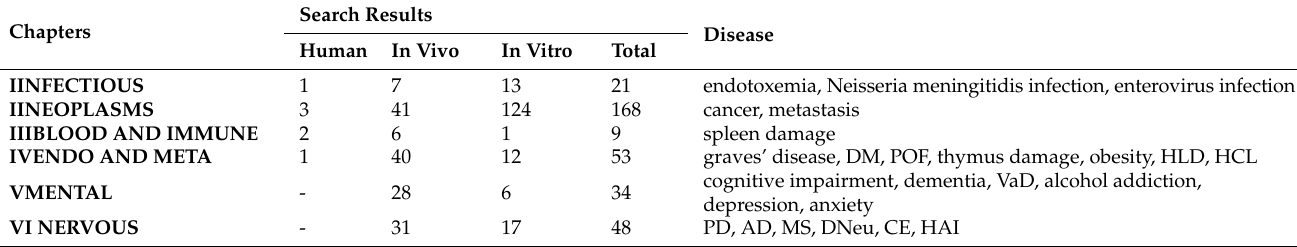
Table 2. Overall pharmacological results of